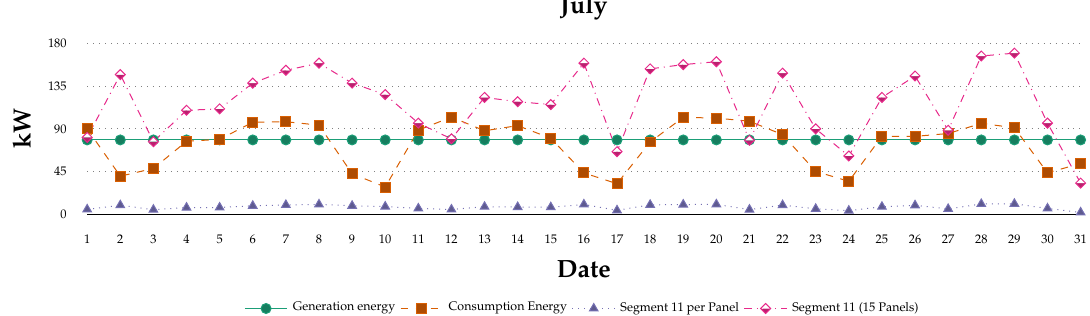
Figure 12. User data with simulated generation energy and grid backup power.